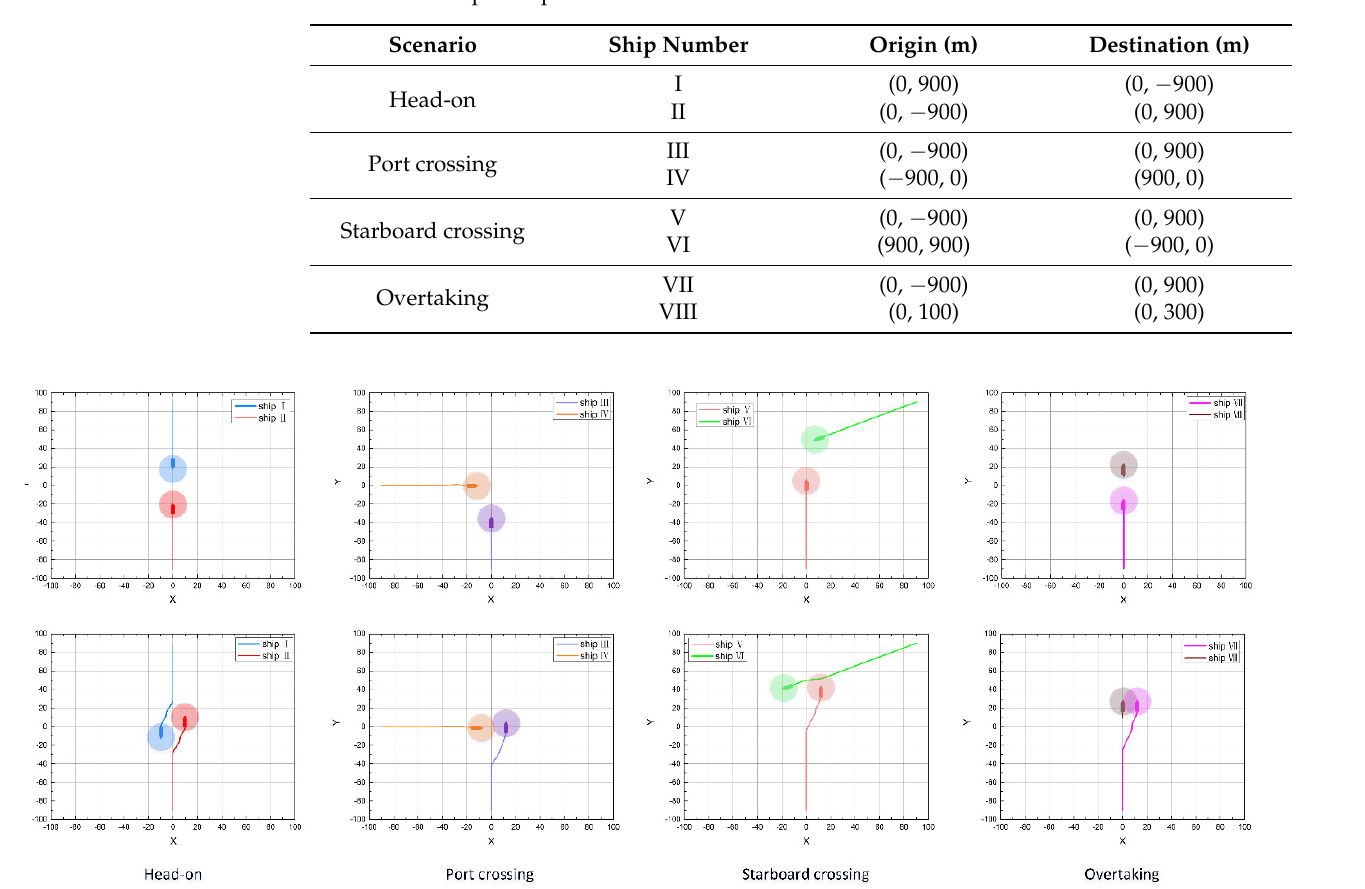
Figure 12. Collision avoidance with four situations based on COLREGs. (Unit: 10 m).